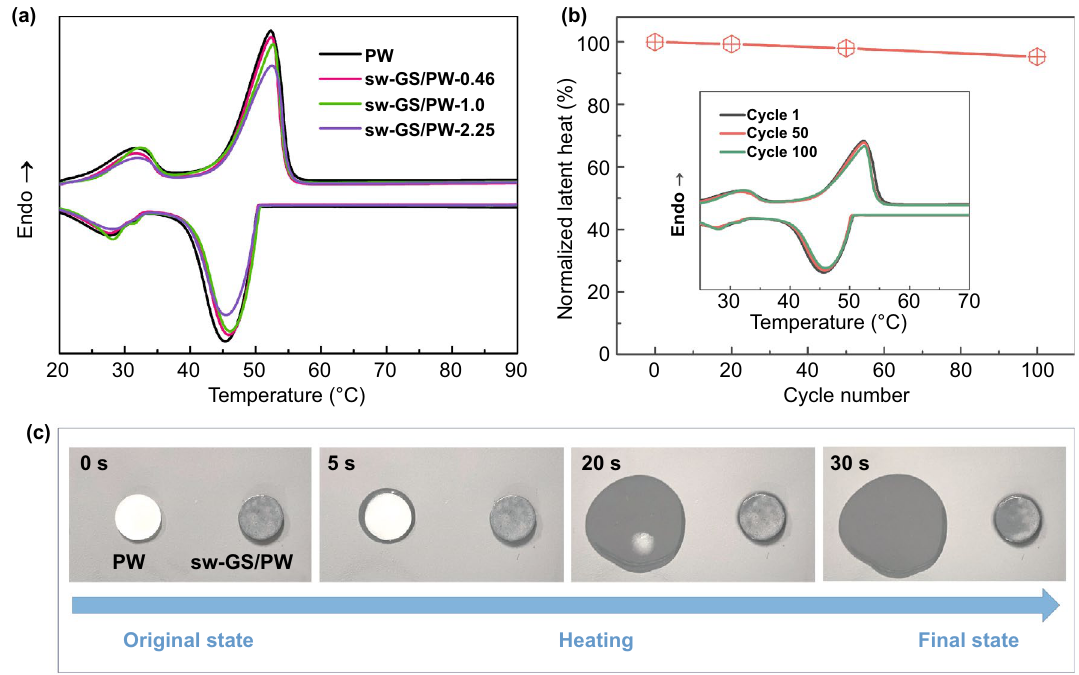
Fig. 3 a DSC curves of PW and sw‑GS/PW composites. b Normalized latent heat of fusion for sw‑GS/PW‑2.25 after thermal cycling (inset shows the DSC curves of sw‑GS/PW‑2.25 up to 100 thermal cycles). c Optical photographs of PW and sw‑GS/PW‑2.25 on a 65 °C hot